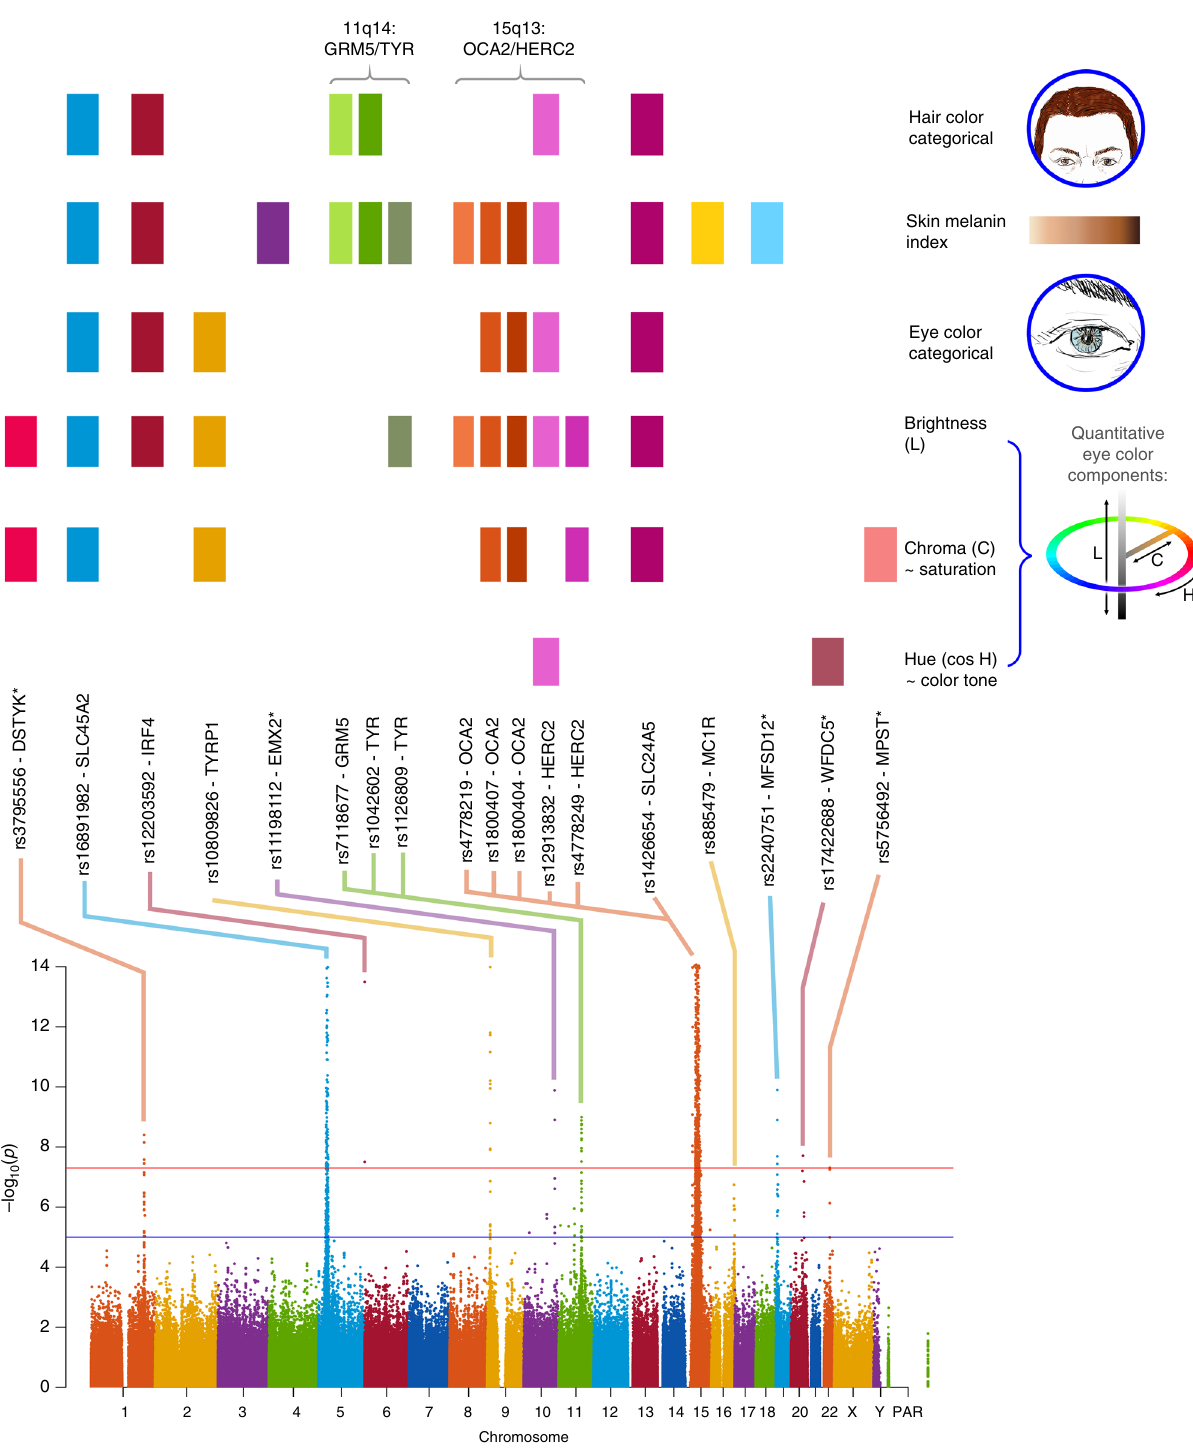
Fig. 3 Summary of GWAS fi ndings. Results are presented for six pigmentation traits: skin melanin index (MI, quantitative), categorical hair color, categorical eye color, and three quantitative eye color variables extracted from digital photographs: L (lightness/brightness), C (chroma/saturation) and cos H (cos hue/tone). These traits are represented on the right. The HCL color space with the three axes of variation is shown in the inset. To provide a global summary of the results, a composite Manhattan plot is presented at the bottom combining signi fi cant signals for all the traits. Horizontal lines indicate the suggestive (blue line, P value = 1 × 10 − 5 ) and signi fi cant (red line, P value = 5 × 10 − 8 ) thresholds. The y -axis was truncated at – log 10 ( P value) = 14. Index SNPs in each region are listed above the Manhattan plot. The association of these SNPs with speci fi c traits is represented by colored boxes at the top: a box is shown if a SNP is associated with that trait (Table 1). Box colors correspond to colors assigned to each chromosome in the Manhattan plot, with slight variation when multiple independent hits were observed on the same chromosome. Novel genomic regions are marked with an